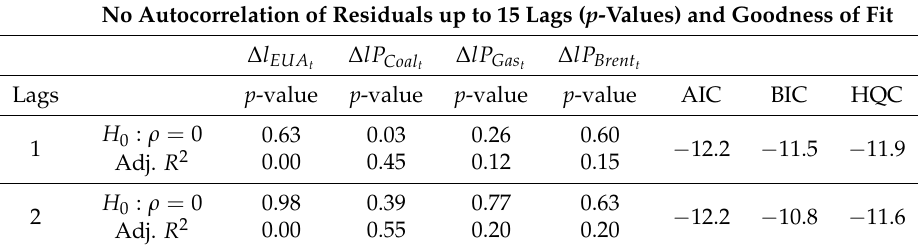
Table 9. Misspecification tests and goodness of fit for VECM with monthly forward prices. No Autocorrelation of Residuals up to 15 Lags ( p -Values) and Goodness of